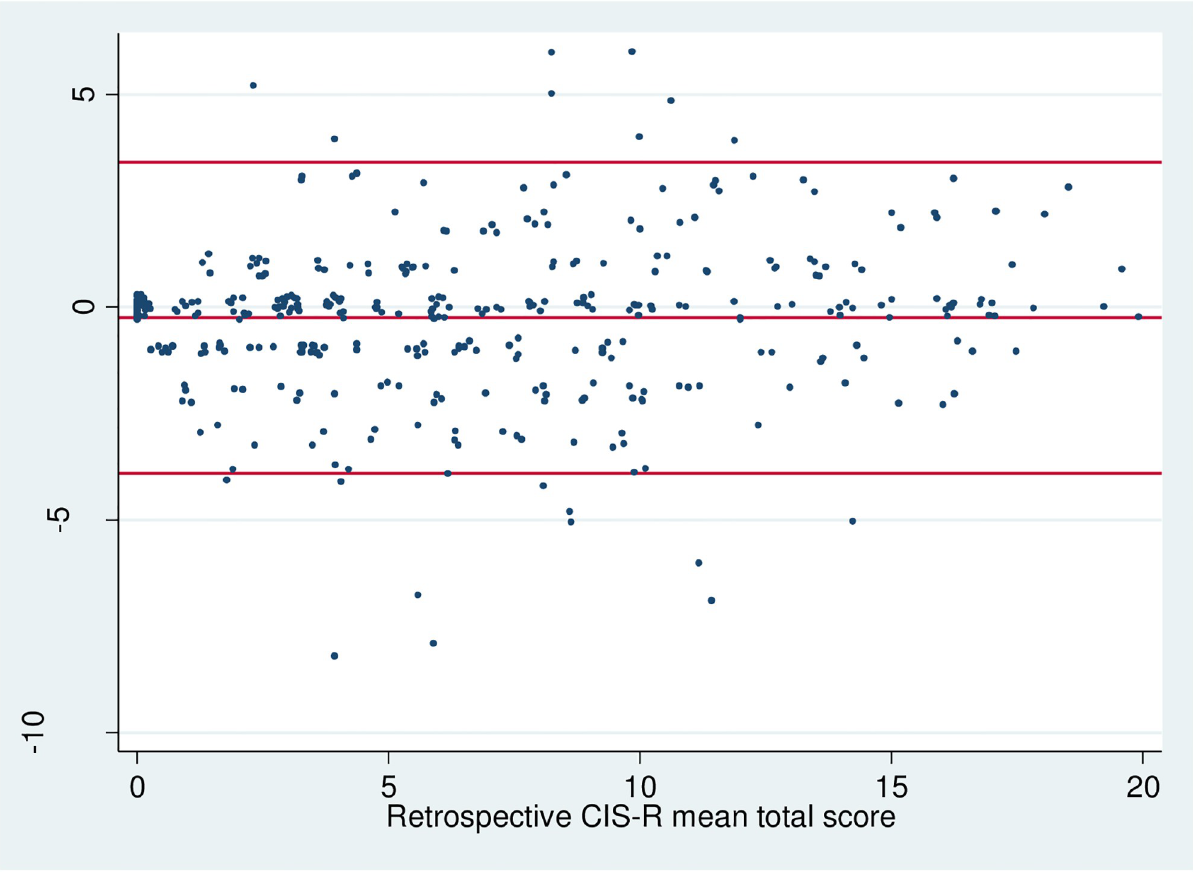
Fig 2. Bland-Altman plot showing the difference in total rCIS-R score against